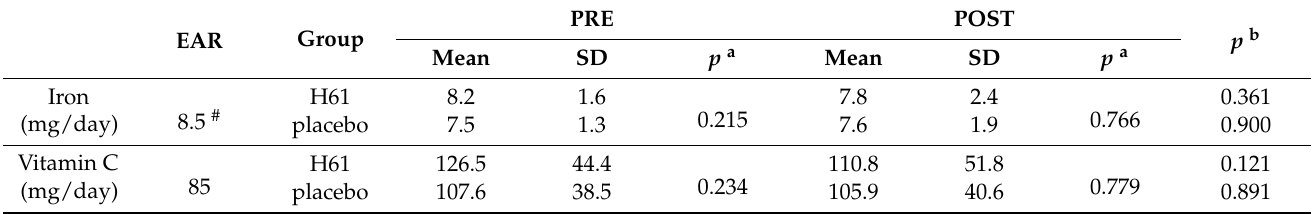
Table 2. Changes in the estimated daily intake of iron and vitamin